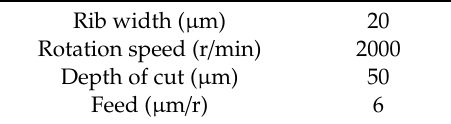
Table 8. The optimal micro cutting parameters.